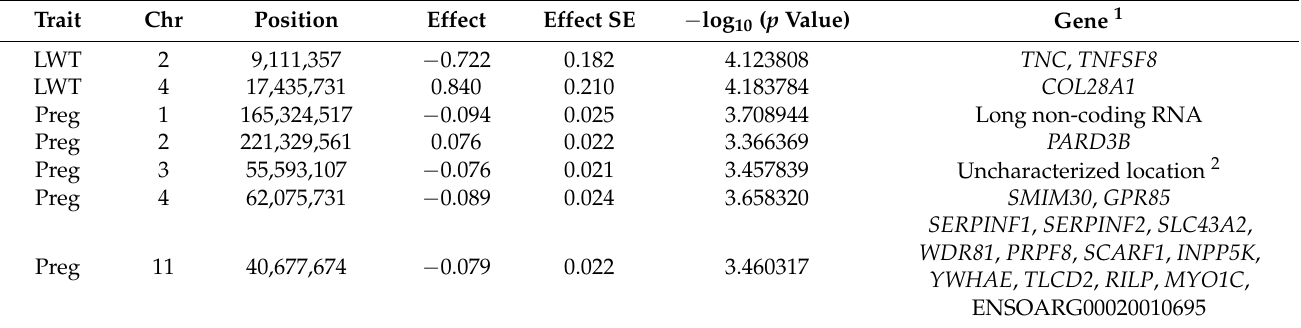
Table 3. Significant SNPs or nearly significant SNP regions (with the most significant SNP reported) associated with ewe lamb live weight (LWT) or the occurrence of pregnancy (Preg) when bred for the first time at eight months of age, chromosome (Chr), position, effect, standard error of the effect (Effect SE), − log 10 ( p value) and gene 1 .